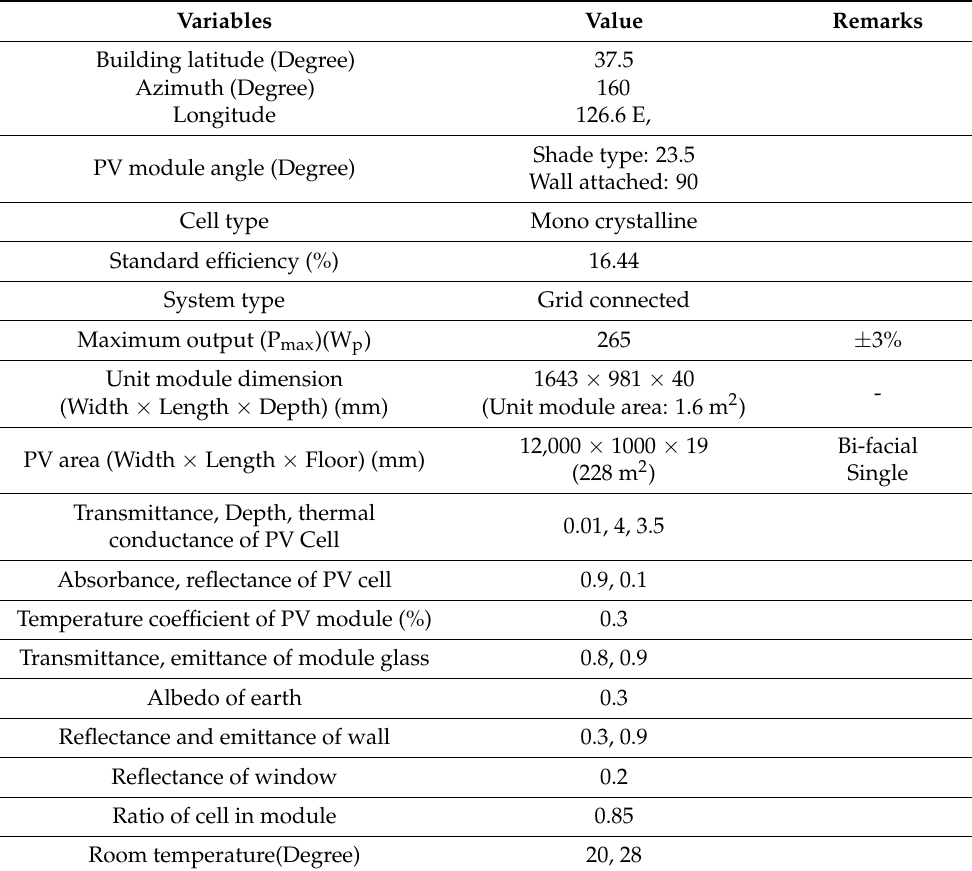
Table 2. Parameter variables for the simulation of the target